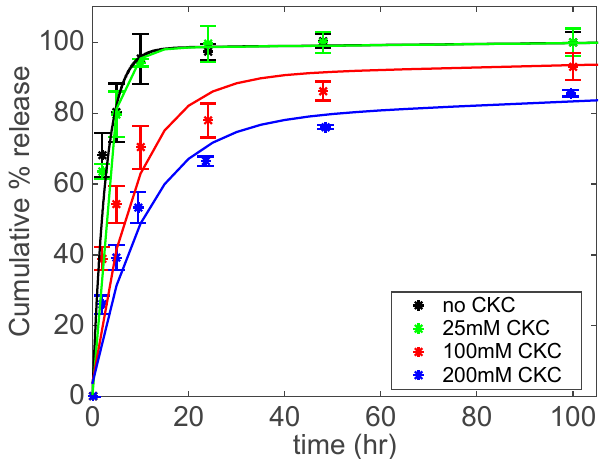
Figure 7. NPNa cumulative % release as a function of time under different CKC concentrations. Catanionic aggregates were prepared at a fixed concentration of NPNa (40 mM) and Brij 97 (20 wt%). Total amount of drug per lens: 106.3 ± 9.1 µg for No CKC; 134.0 ± 3.6 µg for 25 mM CKC; 141.7 ± 14.4 µg for 100 mM CKC; 130.0 ± 8.7 µg for 200 mM CKC. Data are presented as mean ± standard deviation with n = 3.